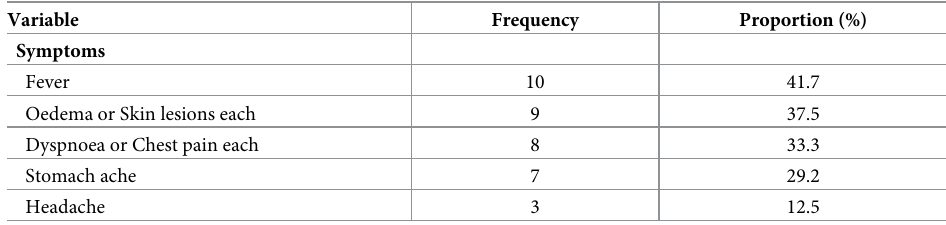
Table 2. Frequency distribution of anthrax symptoms, Kisumu East Sub county 2019 (n = 23).